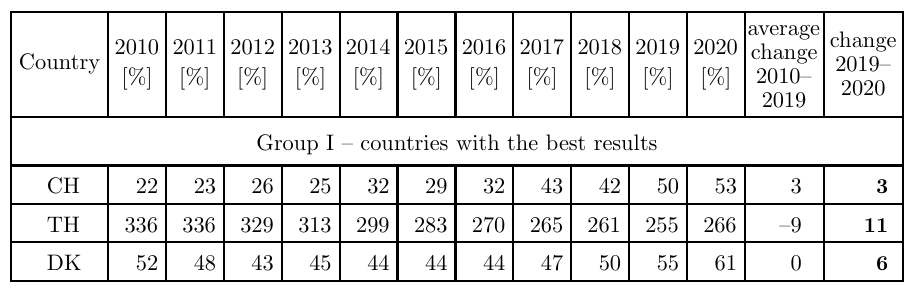
Level and evolution of national net welfare relative to